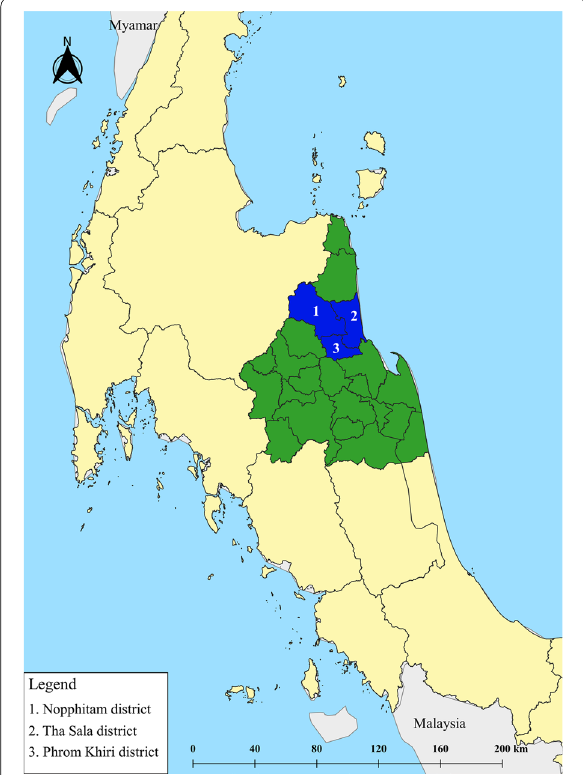
Fig. 1 Map of Nopphitam (1), Tha Sala (2), and Phrom Khiri (3) Districts as study sites. The map was generated using Quantum GIS version 3.16.11 (ESRI